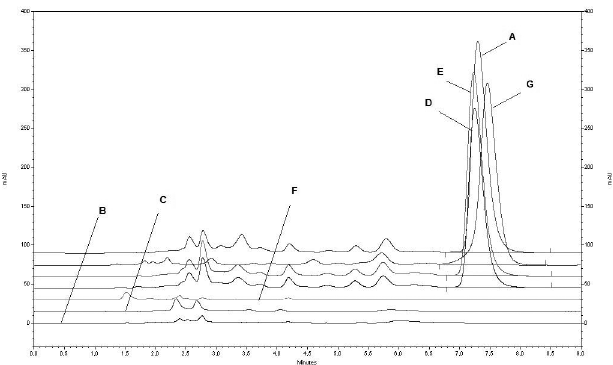
FIGURE 5 - Selectivity Evaluation: Comparison among chromatographic profiles of 100% apramycin working solution